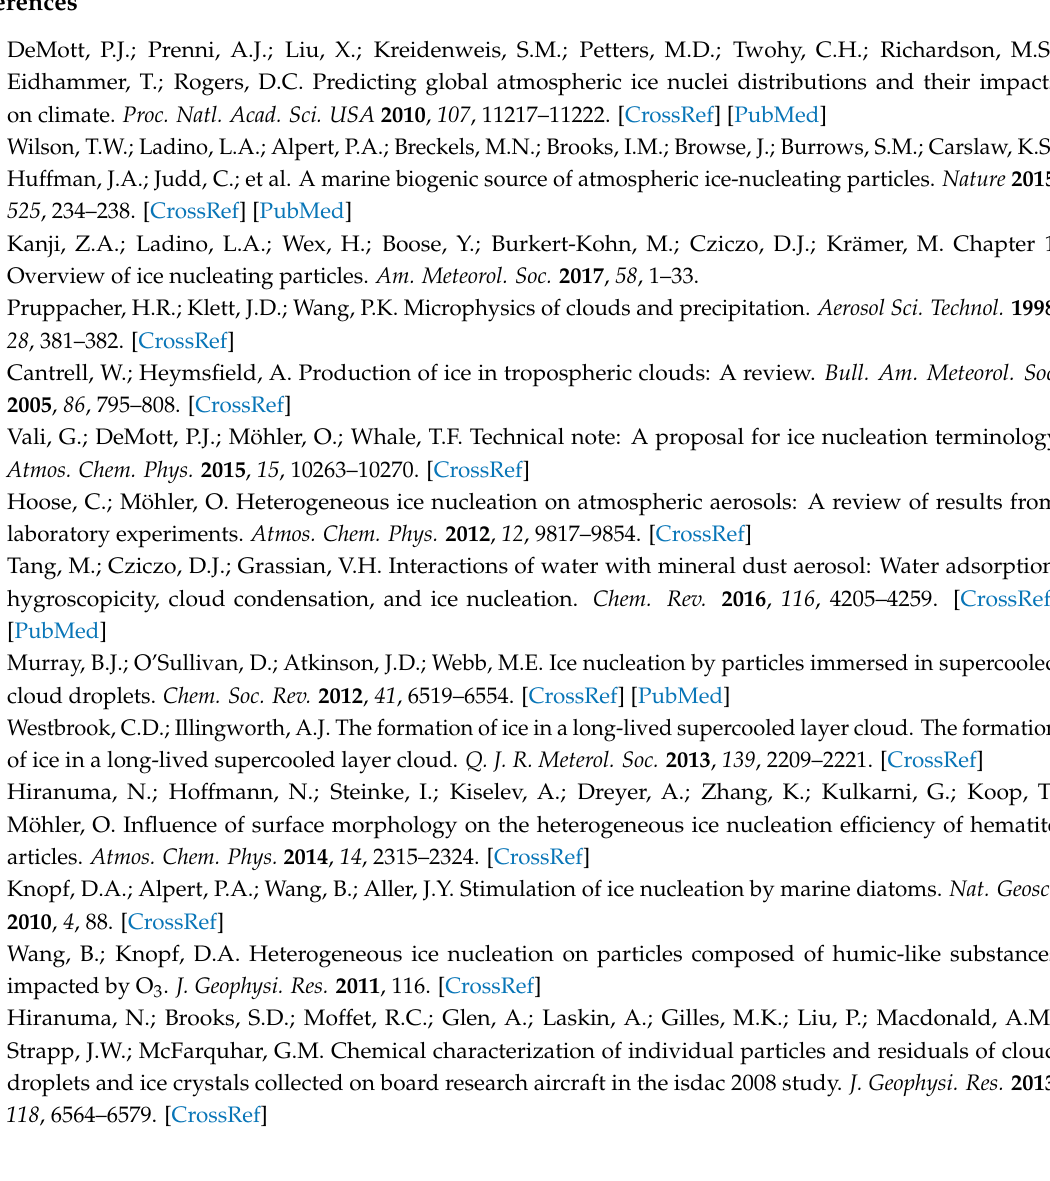
Figure A3. Typical energy dispersive X-ray (EDX) spectra ( a ) and SEM image ( b ) of illite NX particles used in this work.